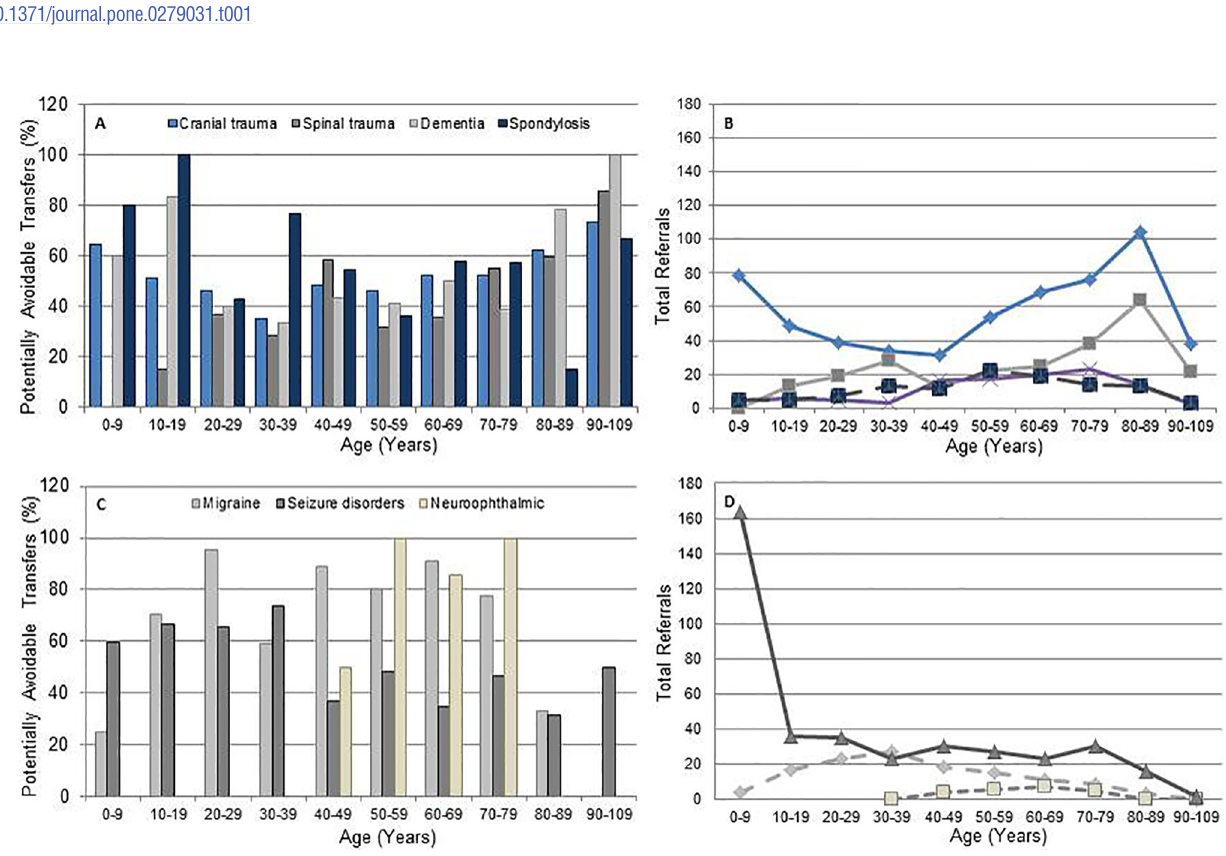
Fig 1. Potentially avoidable transfer proportion correlated with trends in total referrals. (A) Disease categories with high probability of potentially avoidable transfers. (B) Corresponding total referrals showing increasing trends with advancing age. (C) Disease categories associated with significant probability of potentially avoidable transfers. (D) Corresponding total referrals showing declining trends with advancing